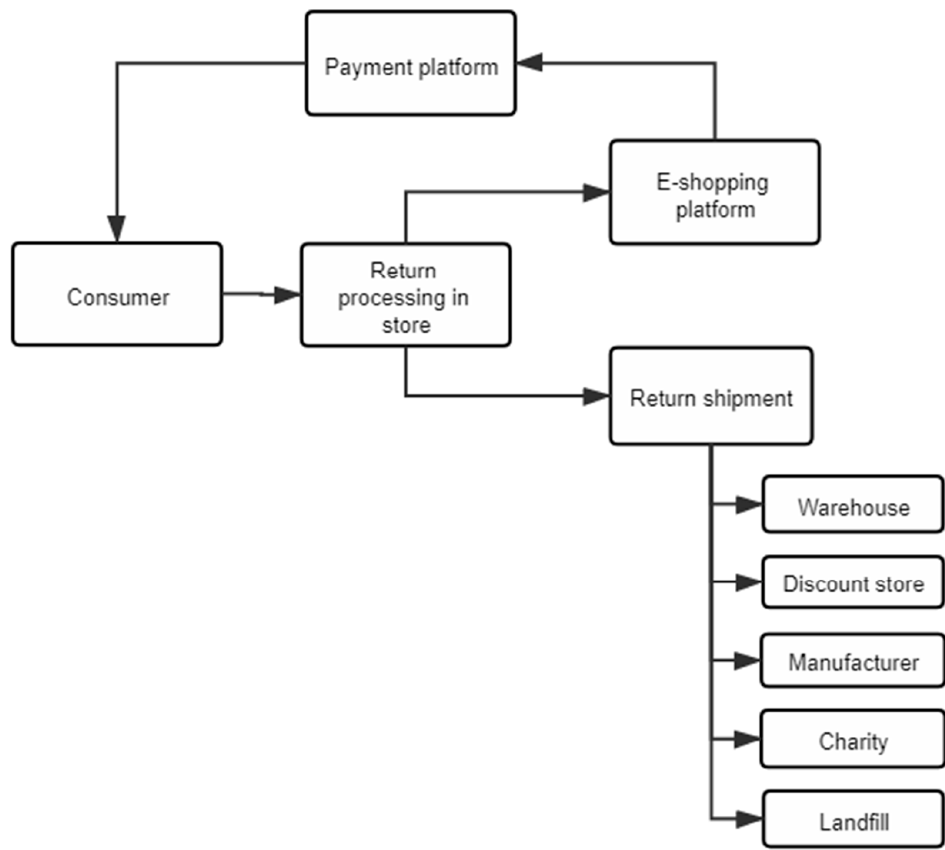
Figure 2. Package-free return